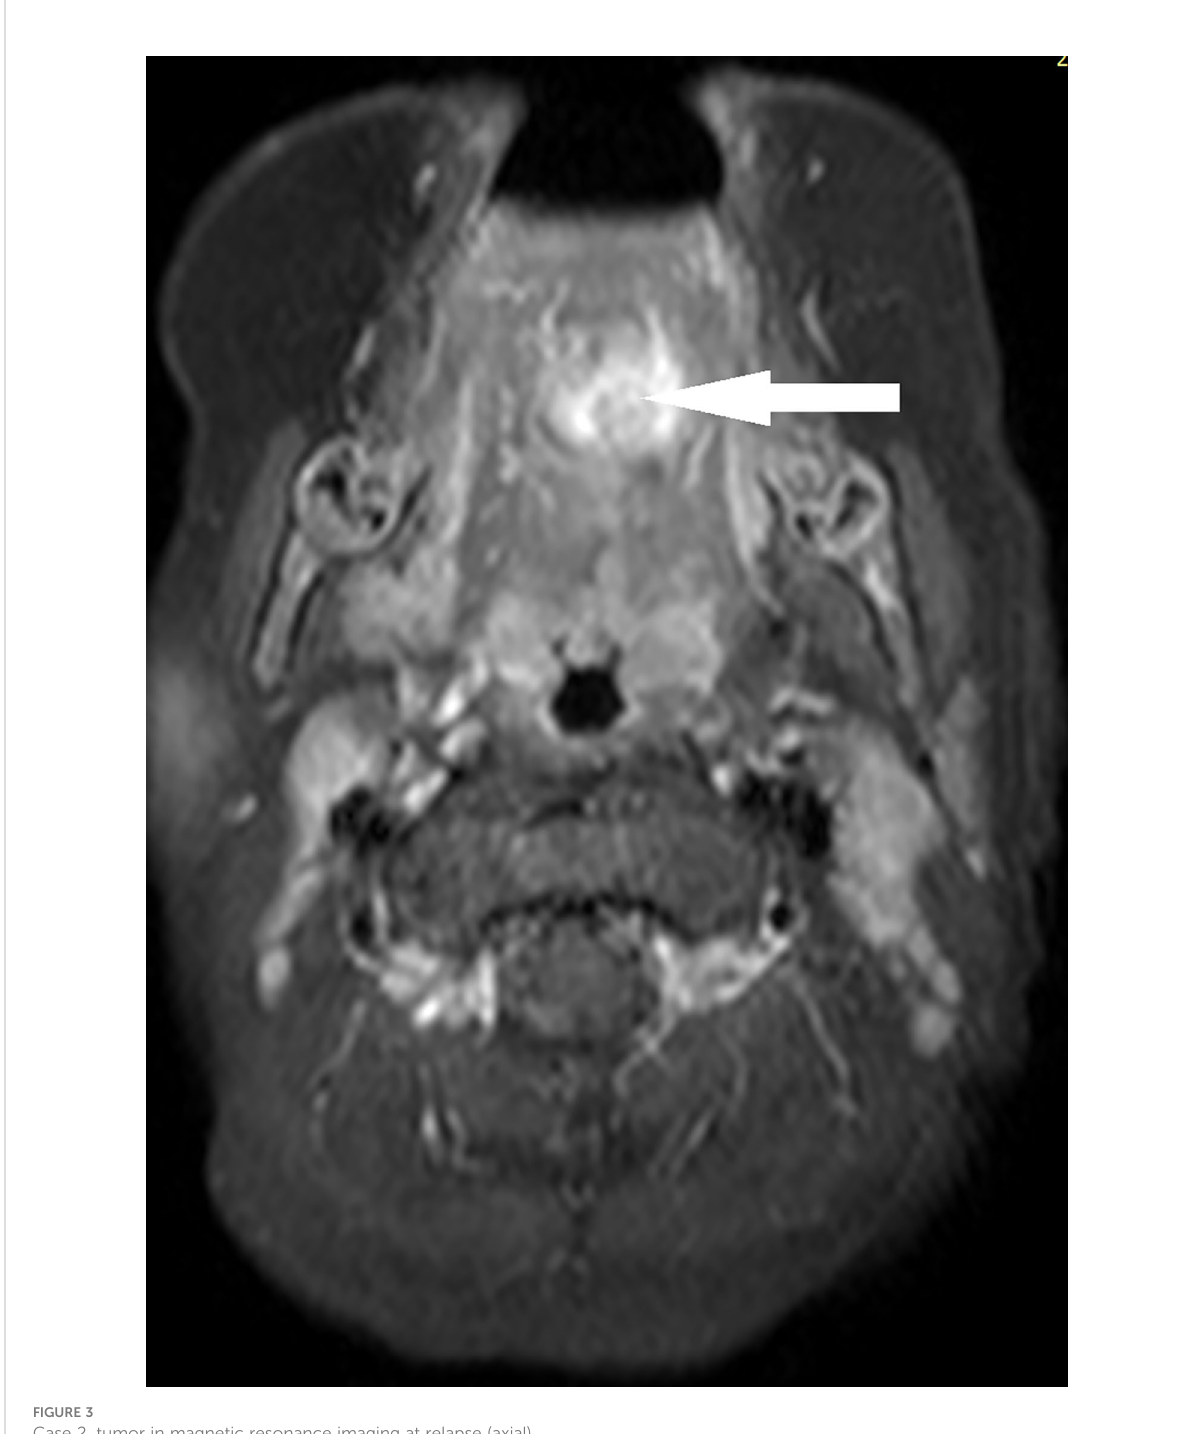
FIGURE 3 Case 2, tumor in magnetic resonance imaging at relapse